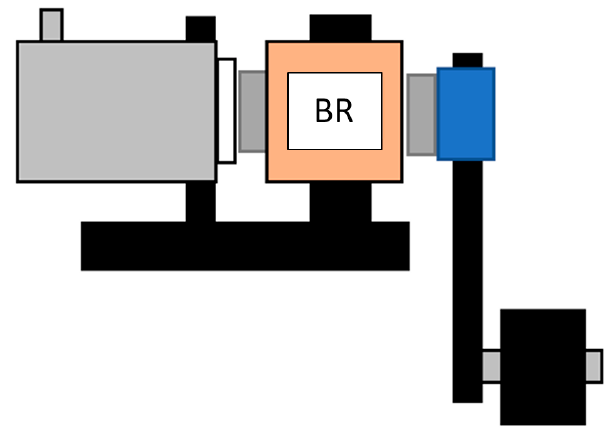
Figure 4. BR connection arrangement in configuration A.